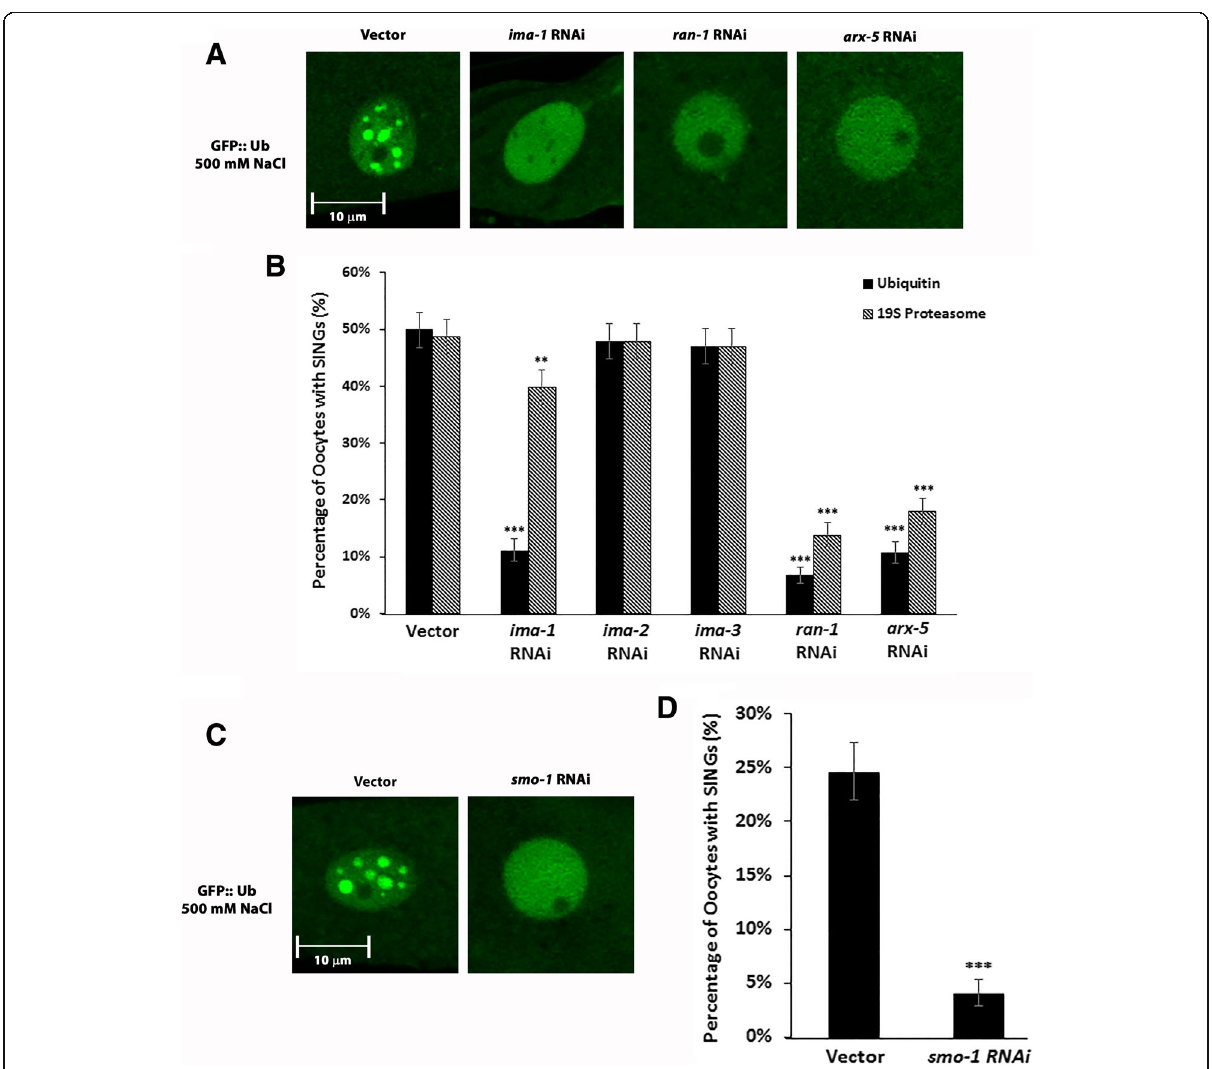
Fig. 3 SING formation required the nuclear import pathway. a RNAi of ima-1, ran-1, and arx-5 reduces SING formation. Worms expressing GFP::Ub in the germline were soaked in 500 mM NaCl for 60 min. Proximal oocytes are shown. Control worms treated with vector RNAi formed SINGS normally. Scale bar indicates 10 μ m. b The percentage of oocytes forming SINGs after treatment as described in A. Oocytes were scored for both GFP::Ub and RPT-1::mCh at SINGs. A total of 1020 oocytes were analyzed for each condition from 3 independent experiments ( n = 30 worms). Statistical significance was calculated by a two-tailed z test: ** p < 0.01 and *** p < 0.001. c RNAi of smo-1 reduces SING formation in a worm strain expressing GFP::Ub in the germline. Proximal oocytes are shown. Scale bar indicates 10 μ m. d The percentage of oocytes forming SINGs after treatment as described in C. A total of 1020 oocytes were analyzed from 3 independent experiments ( n = 30 worms). Statistical significance was calculated by a two-tailed z test: *** p <